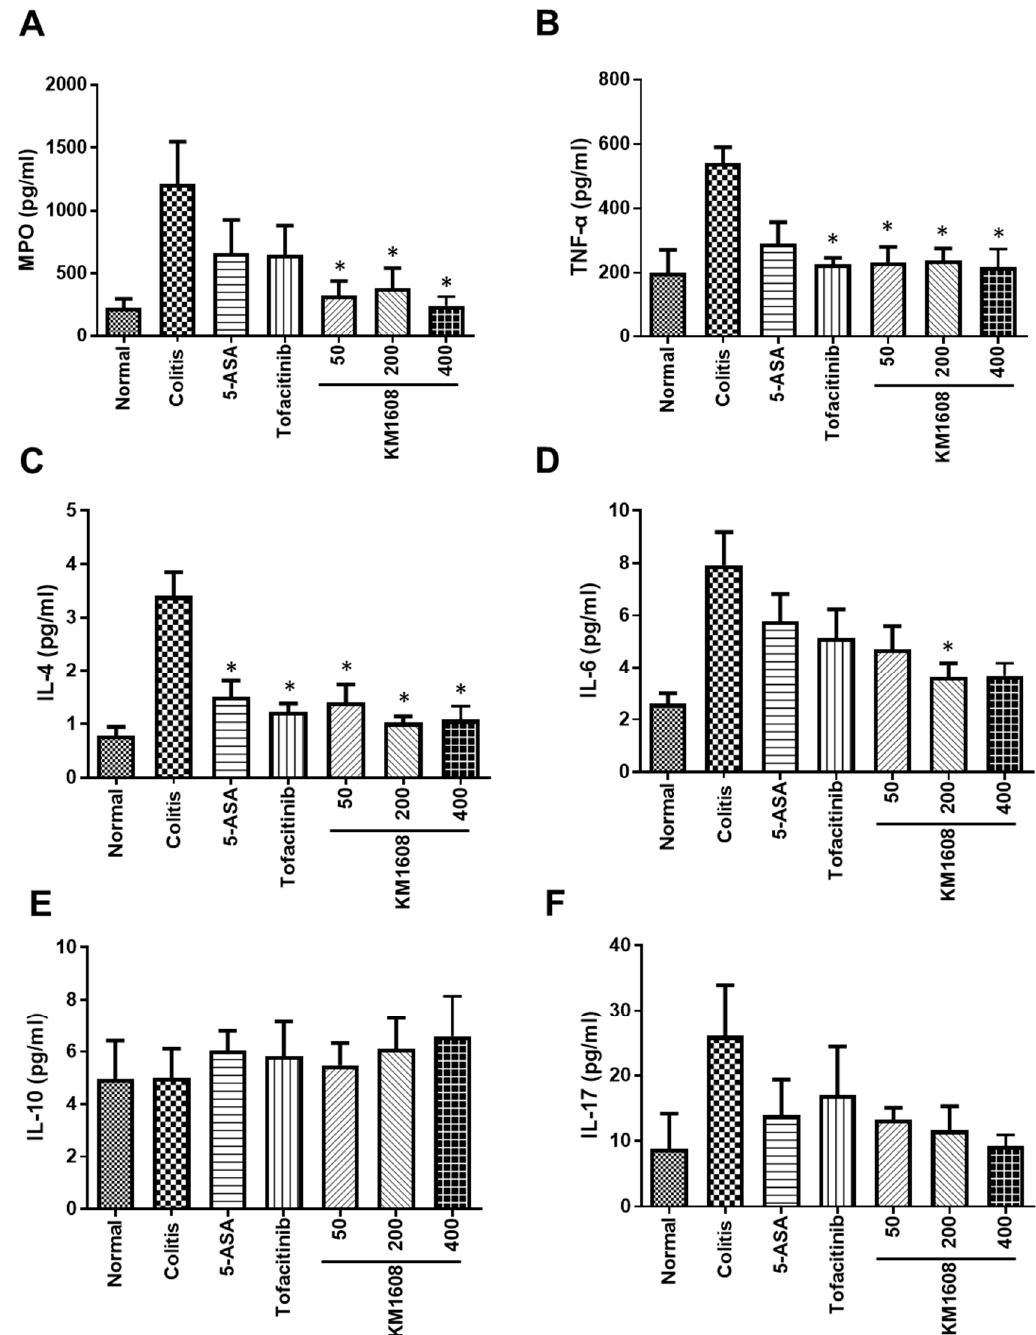
Figure 4. Myeloperoxidase (MPO) and cytokine (TNF- α , IL-4, IL-6, IL-10, and IL-17) levels in the colitis-induced colon were measured by ELISA. MPO ( A ), TNF- α ( B ), IL-4 ( C ), IL-6 ( D ), and IL-17 ( F ) levels were lower in KM1608 treatment than those in colitis mice. IL-10 was not changed in the colon ( E ). Data are presented as the mean ± SEM. n = 3–5, * p < 0.05 vs. colitis. IL-10 is a regulatory cytokine that suppresses proinflammatory cytokine production to maintain homeostasis [19]. A previous study has reported that C57BL/6 IL-10-deficient mice show more exacerbated colitis upon DSS administration than wild-type mice [20]. However, another study has